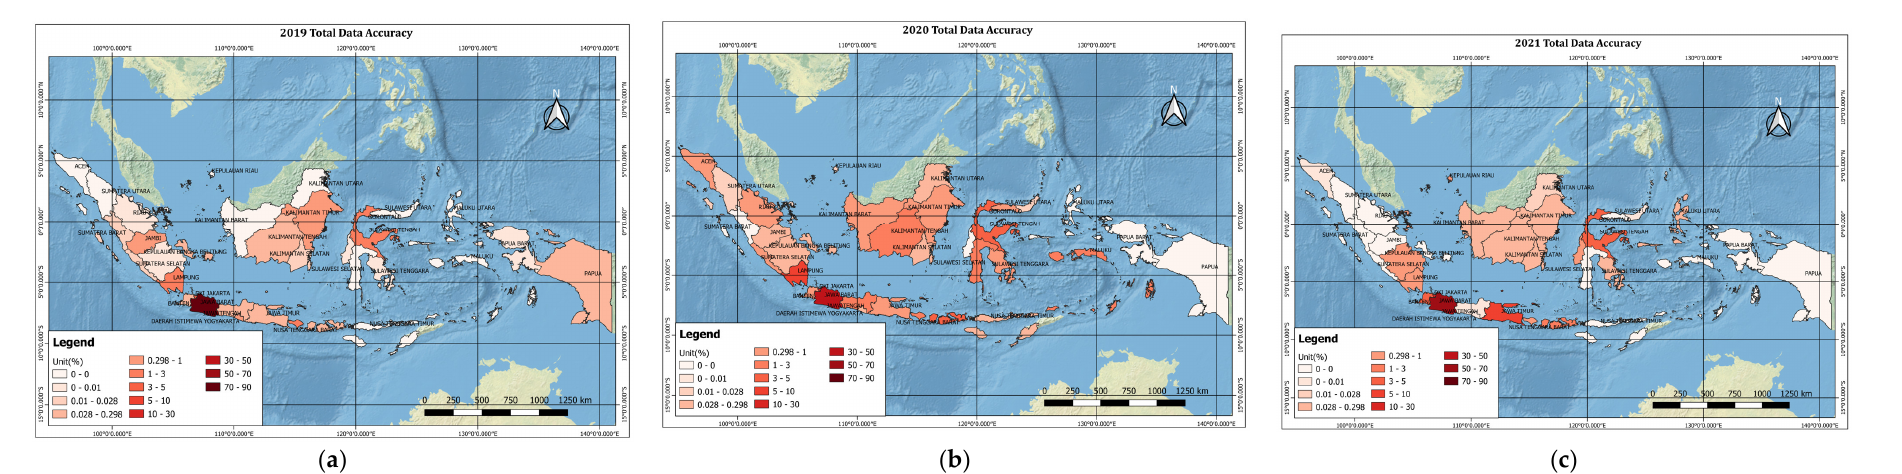
Figure 2. Total data accuracy figure from 2019–2021: ( a ) 2019; ( b ) 2020; ( c ) 2021.